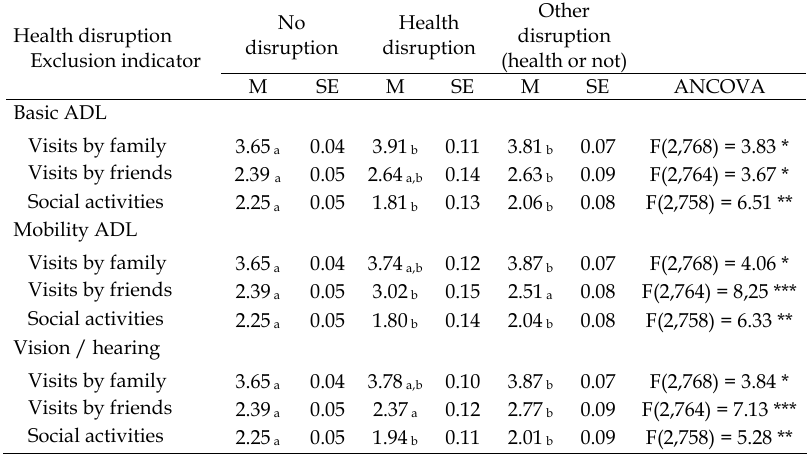
Table 4 . Adjusted means, standard errors and analysis of